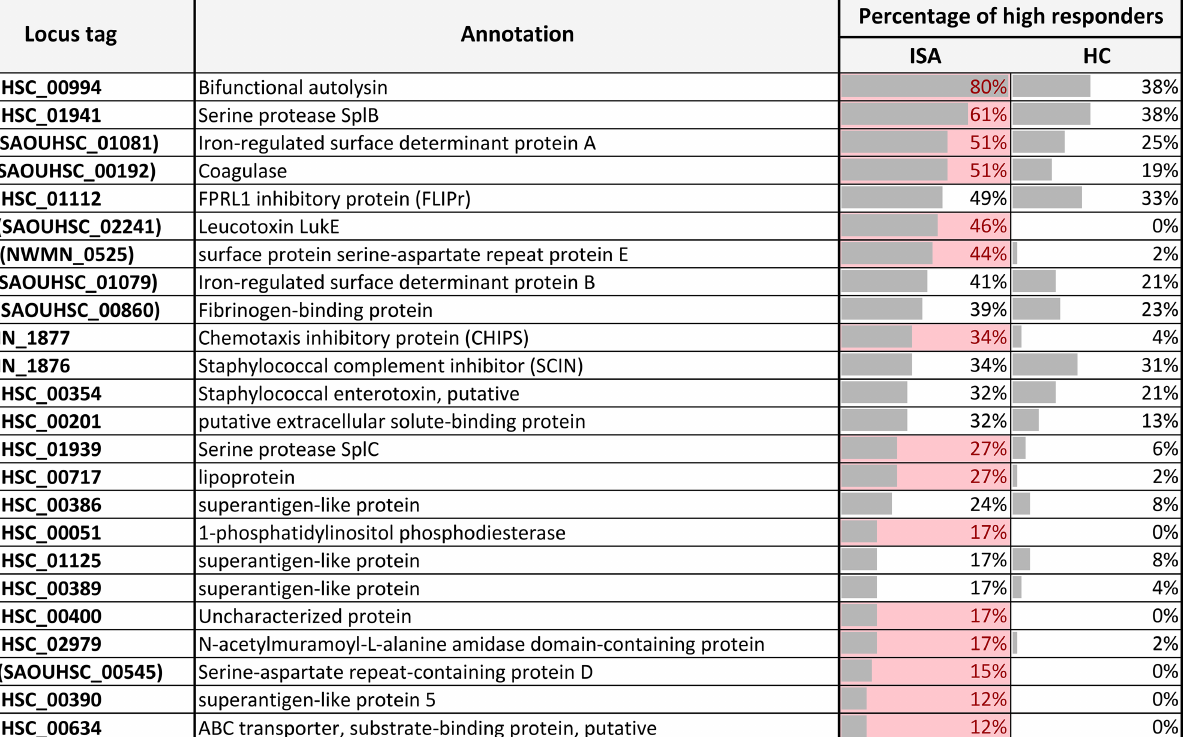
TABLE 1 | Best recognized S. aureus antigens in protein chip